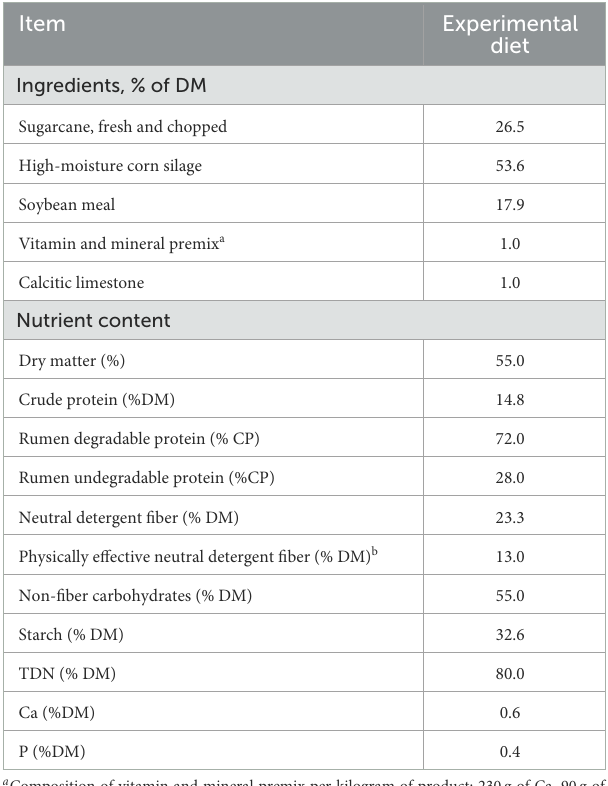
TABLE 1 Feed ingredients and chemical composition of the experimental